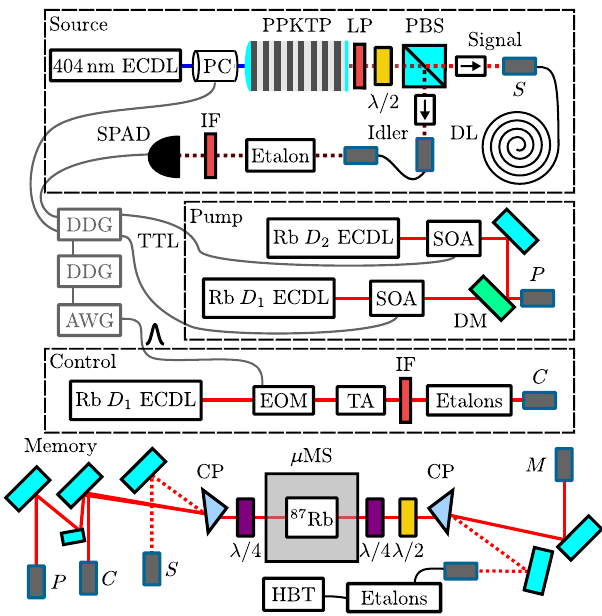
FIG. 2. Experimental setup: ECDL, external cavity diode laser; PC, Pockels cell; PPKTP, monolithic periodically poled potassium titanyl phosphate cavity; LP, optical longpass; PBS, polarizing beam splitter; IF, interference filter; SPAD, single- photon avalanche diode; DL, 60 m fiber delay line; DDG, digital delay generator; AWG, arbitrary waveform generator; SOA, semiconductor optical amplifier (fiber connections omit- ted); DM, dichroic mirror; EOM, electro-optic modulator (fiber connections omitted); TA, tapered amplifier; CP, calcite polariz- ing prism; λ/ 2, half-wave plate; λ/ 4, quarter-wave plate; μ MS, four-layer mu-metal magnetic shield; HBT, Hanbury Brown and Twiss configured single-photon detectors; M , fiber connection for monitoring the control. The labels S , P , and C represent the fiber connections of the signal, pump, and control to the memory,